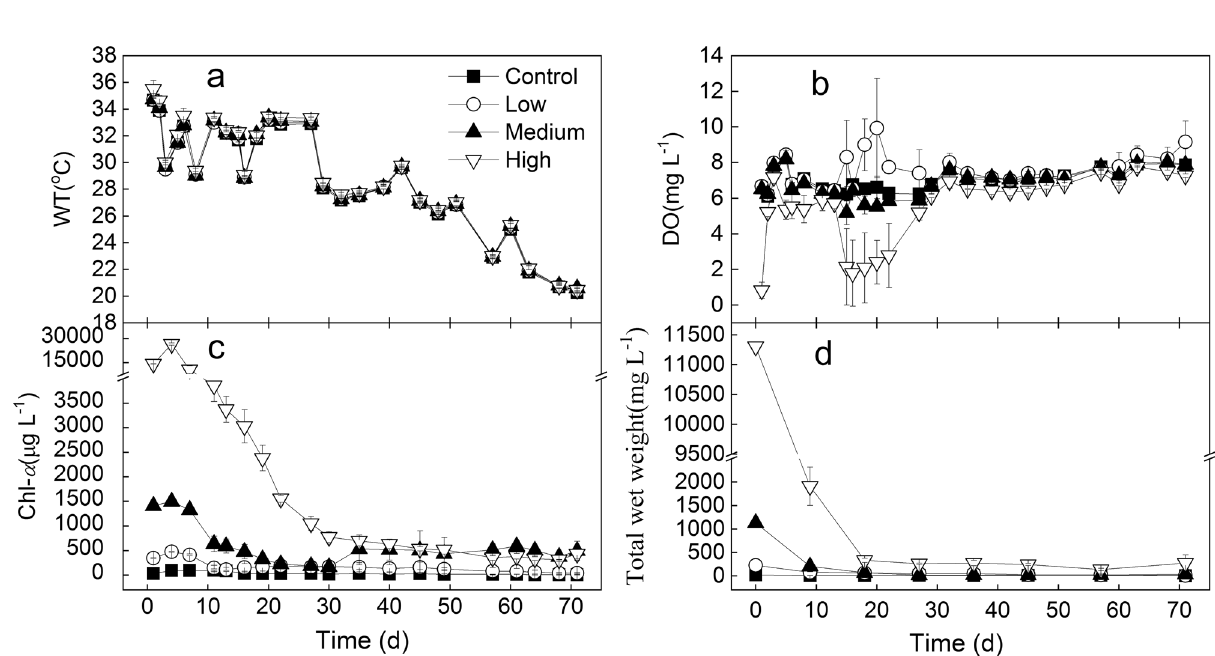
Figure 1. The changes in WT ( a ), DO ( b ), Chl- a ( c ) and algal wet weight ( d ) in the four